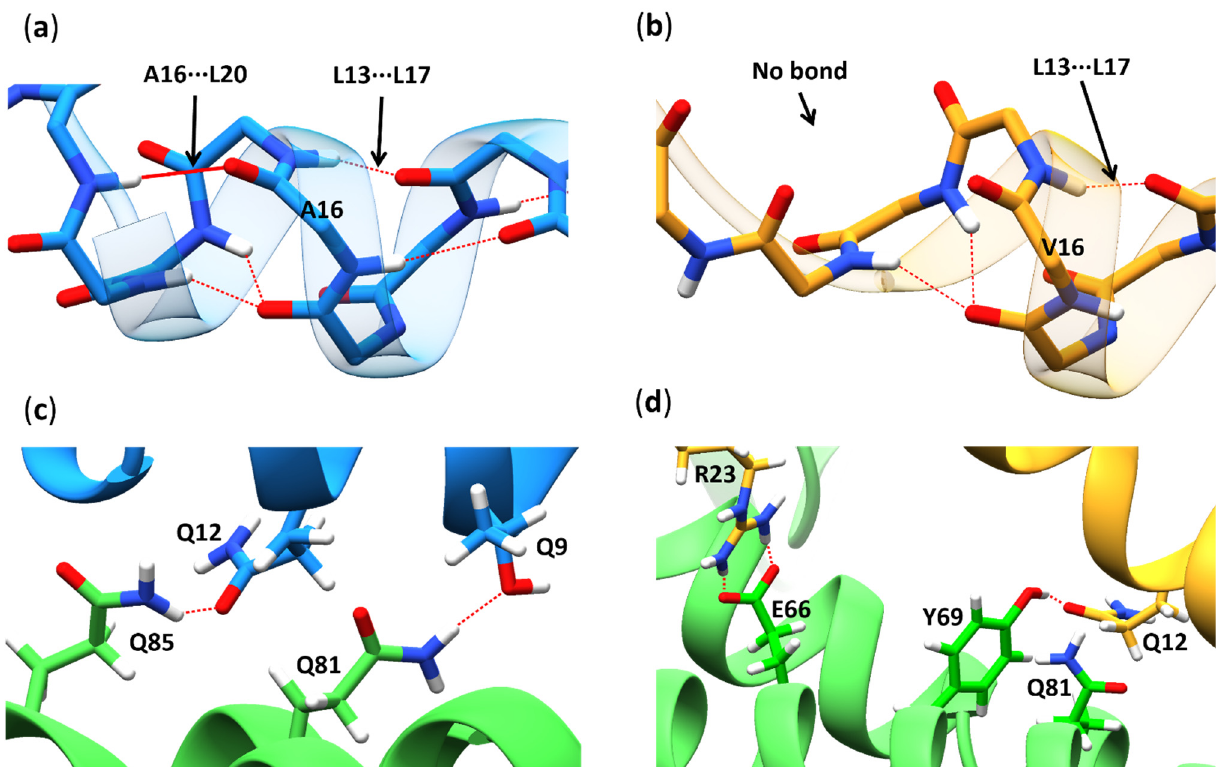
Figure 5. Visual representation of the essential hydrogen bonds. ( a ) Ala16 formed a standard α - helical hydrogen bond with Leu20 (solid red line) already at the beginning of the MD simulation (at 1 ns), and it remained the most stable hydrogen bond throughout the trajectory (Table 2). ( b ) Val16 did not form a hydrogen bond with Leu20 during the MD simulation. ( c ) The MTS α -helix was stabilized by forming intermolecular hydrogen bonds with the MnSOD protein α -helix (amino acid residues 78–103) Thr9···Gln81 and Gln12···Gln85 for the alanine variant, ( d ) and Gln12···Tyr69 and Gln12···Gln81 for the valine variant, but never concurrently. Both MTSs were held in place by the intermolecular Arg23···Glu66 hydrogen bonds. Dotted red lines depict hydrogen bonds, blue color the Ala-MTS, yellow color the Val-MTS, and green color the rest of the MnSOD protein. Based on the RMSD values calculated for the rest of the protein (amino acid residues